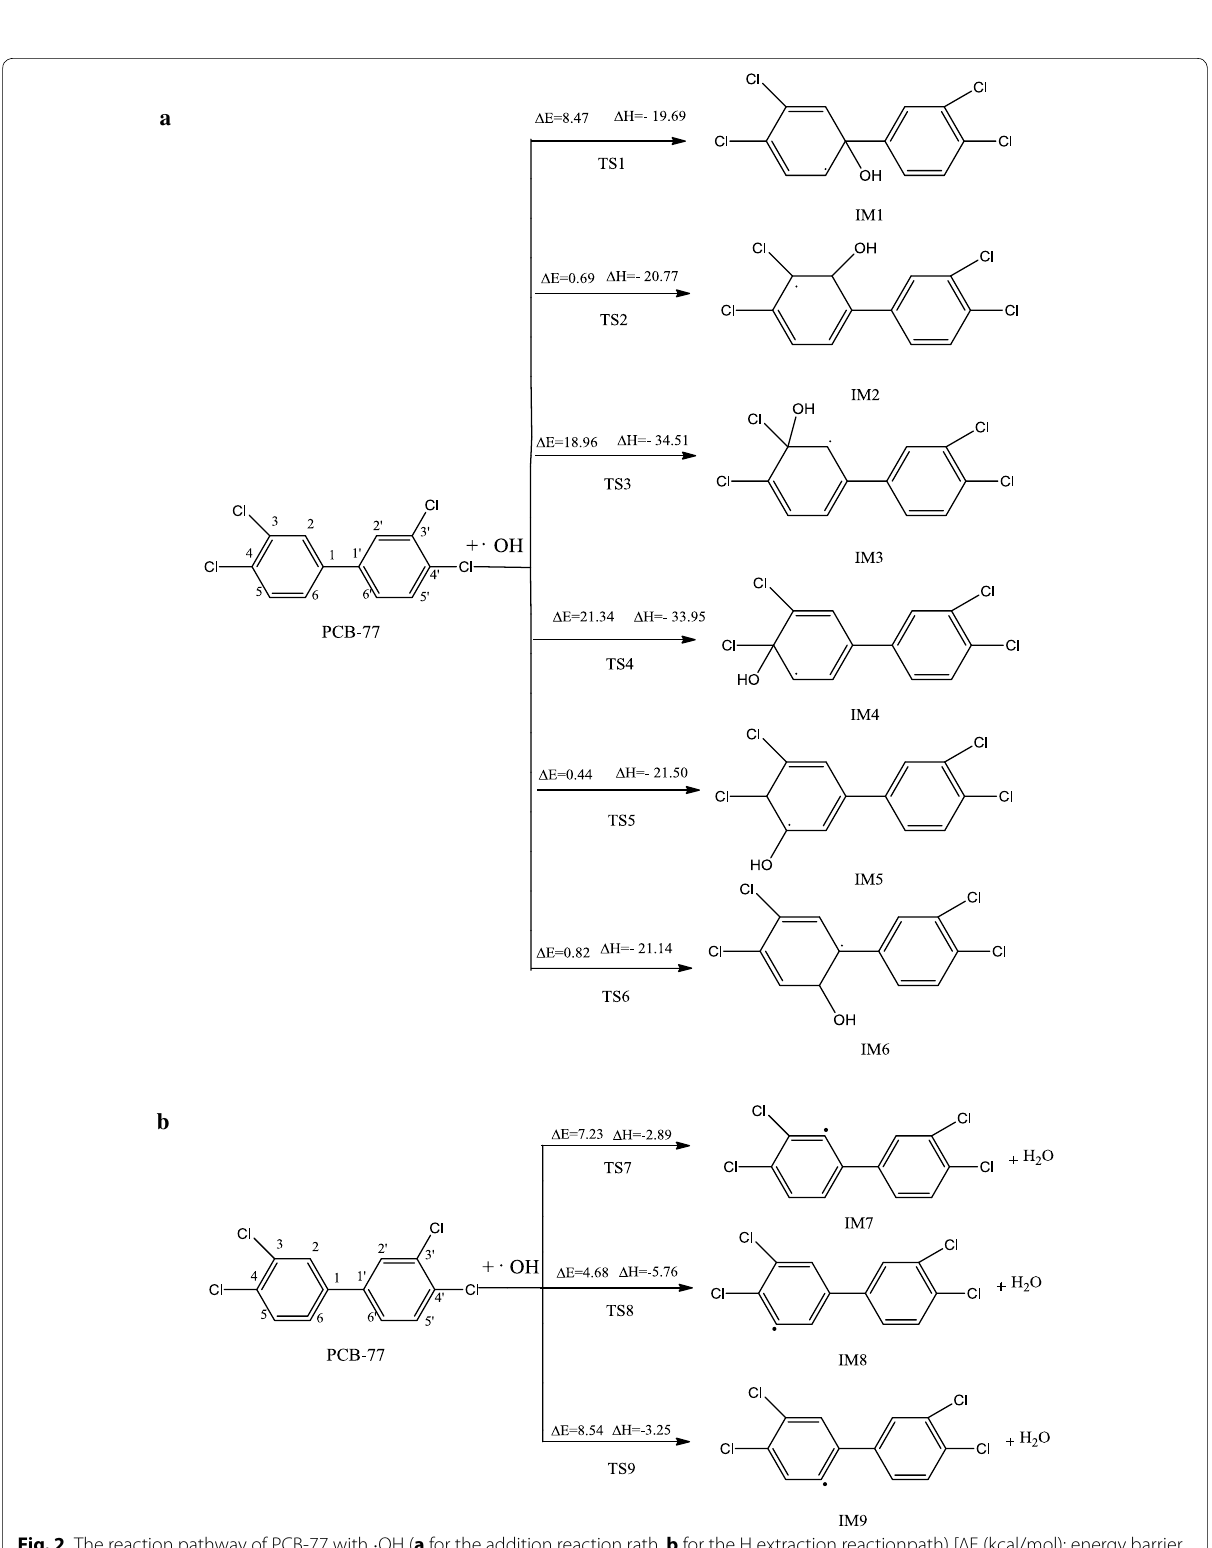
Fig. 2 The reaction pathway of PCB‑77 with ∆H (kcal/mol): reaction